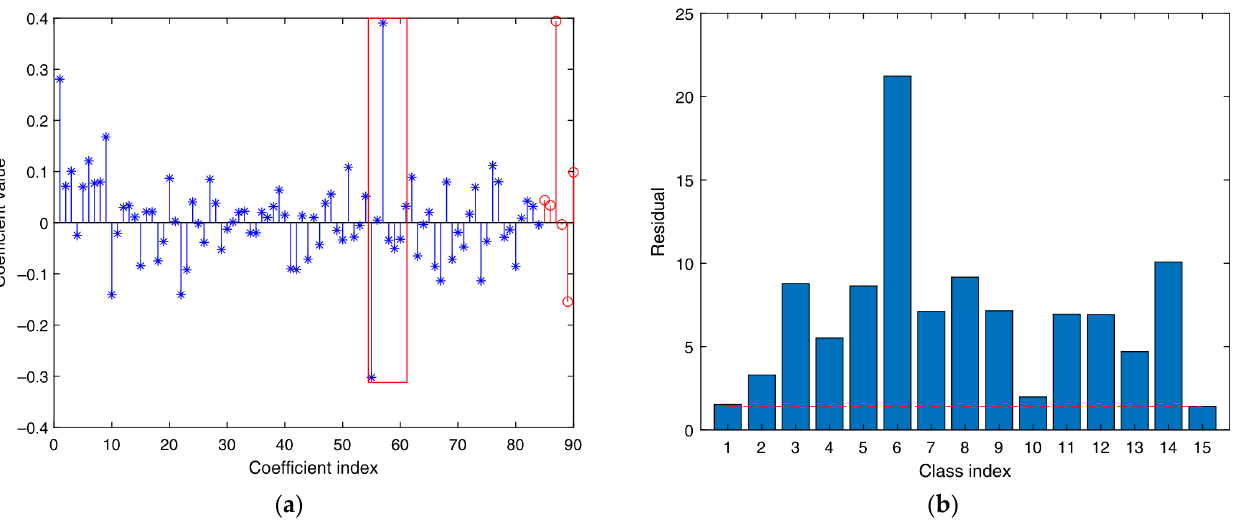
Figure 3. ( a ) Coefficients obtained by the original algorithm; ( b ) residuals obtained by the original algorithm.